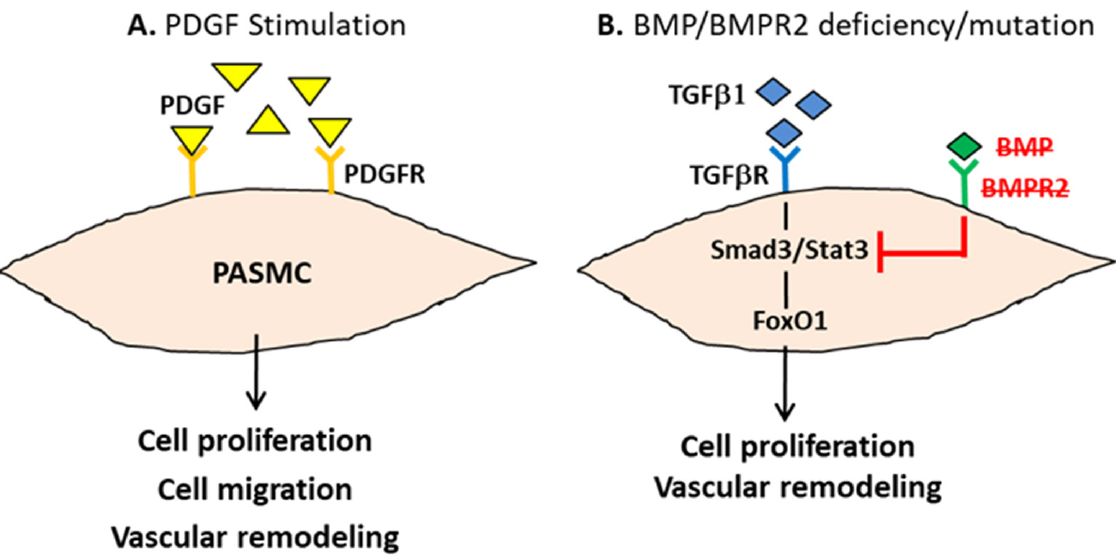
Figure 2. The crucial roles of PDGF stimulation and BMP/BMPR2 aberration in PAH pathogenesis . ( A ) PDGF binds to its receptor tyrosine kinase PDGFR to trigger cell proliferation and migration in PASMCs, which further leads to vascular remodeling. ( B ) BMP deficiency or BMPR2 mutation results in an impaired antagonistic activity to suppress TGF β 1-Stat3-FoxO1 signaling-induced PASMCs proliferation and vascular remodeling.